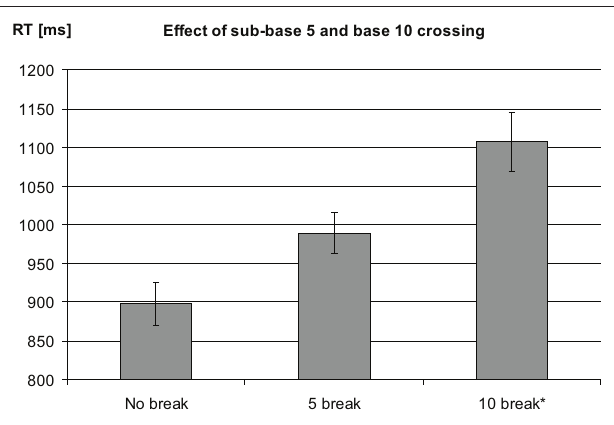
Table 2 | results for all variables entered in the stepwise multiple regression